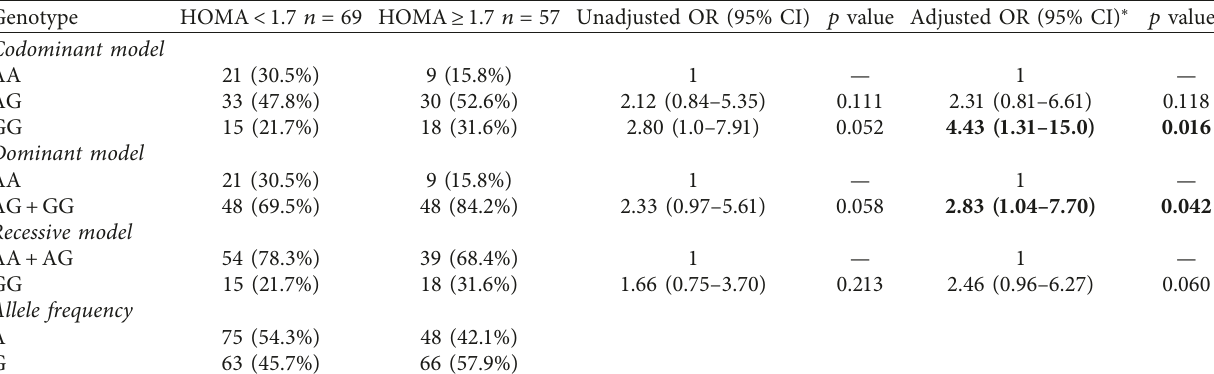
Table 3: Genotype distribution and allele frequency of ADRB2 rs1042713 in insulin-resistant and non-insulin-resistant groups. Genotype